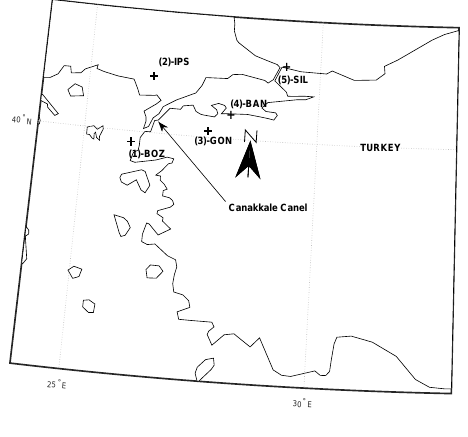
Figure 2. The measurement stations, Bozcaada (BOZ), Ipsala (IPS), Gonen (GON), Bandirma (BAN), and Sile (SIL) of Turkey where N indicates the